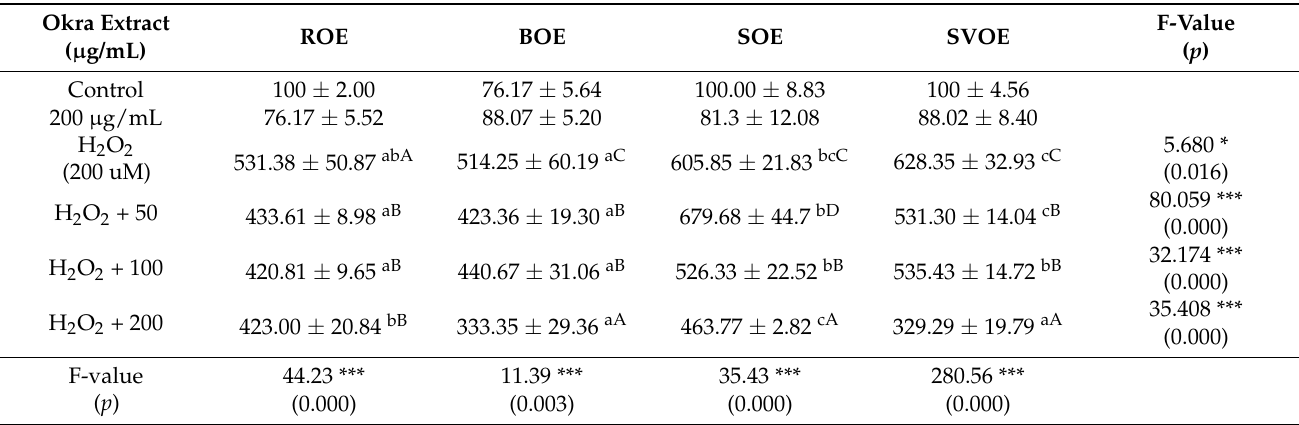
Table 3. Effect of okra extract on reactive oxygen species (ROS) production in hydrogen peroxide (H 2 O 2 )-induced RAW264.7 cells.